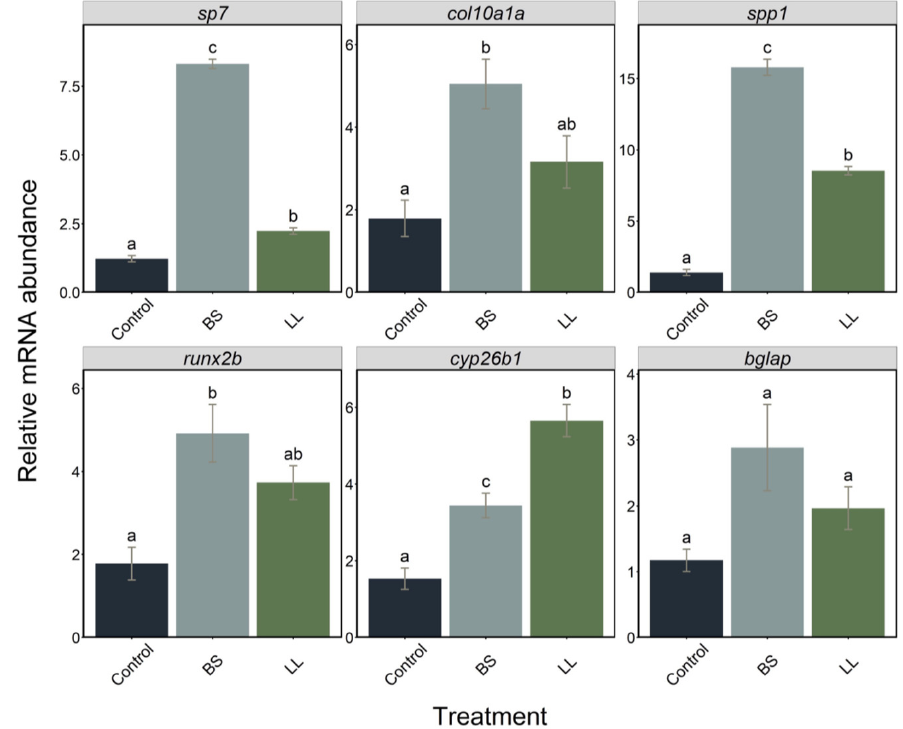
Figure 3. Relative expression levels of sp7 , col10a1a , spp1 , runx2b , cyp26b1 and bglap genes in larvae ( n = 7) treated with two probiotics, BS and LL, sampled at 7 dpf. Data are presented as mean ± S.D. One-way ANOVA and Tukey’s multiple comparison tests are used. Different letters denote statistically significant differences ( p < 0.05) between the experimental groups.